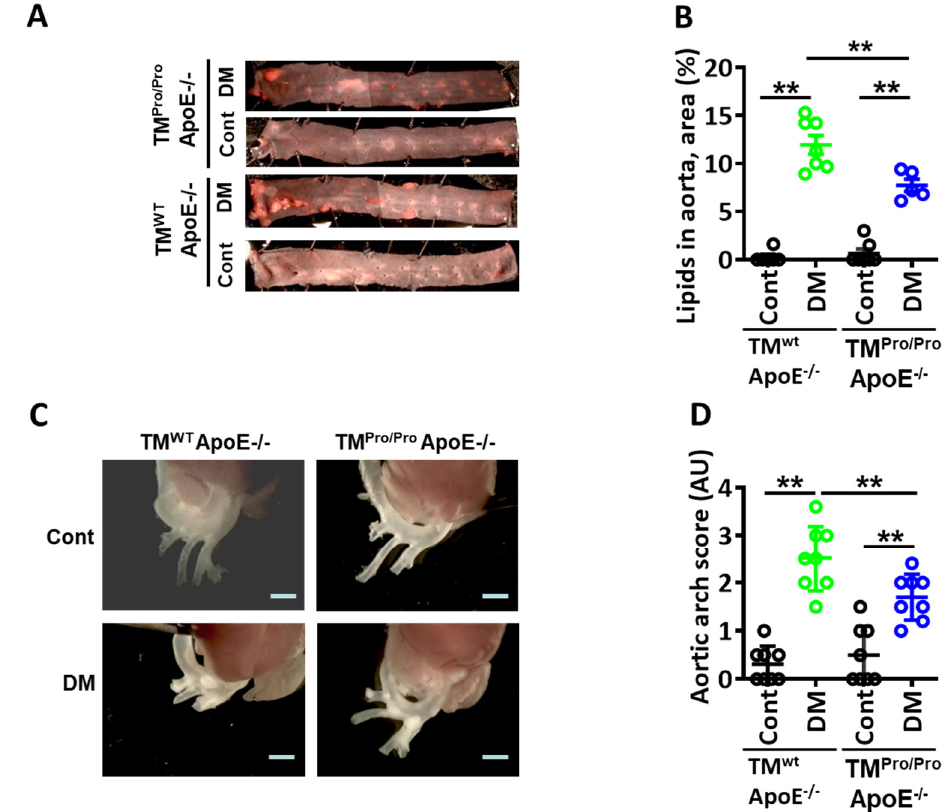
Figure 2. Smaller plaques in hyperglycemic TM Pro/Pro ApoE -/- versus hyperglycemic ApoE -/- mice. ( A , B ): Representative images of thoracic aortae showing en face plaques as detected by Oil Red O staining ( A ) and dot-plot summarizing data (total area stained with Oil Red O, B ) in control (normal chow diet, Cont) and diabetic (STZ-induced hyperglycemia, DM) mice. Representative images showing plaques within the aortic arch vessel ( C ) and dot plot summarizing plaque score ( D ). ApoE -/- and TM Pro/Pro ApoE -/- control mice (Cont, normal chow diet, citrate instead of streptozotocin injections), ApoE-/- DM mice and TM Pro/Pro ApoE -/- DM (normal chow diet, streptozotocin injections). Each dot represents data obtained from one mouse specimen (n = at least 6 mice per group); ** p < 0.01; two-way ANOVA.